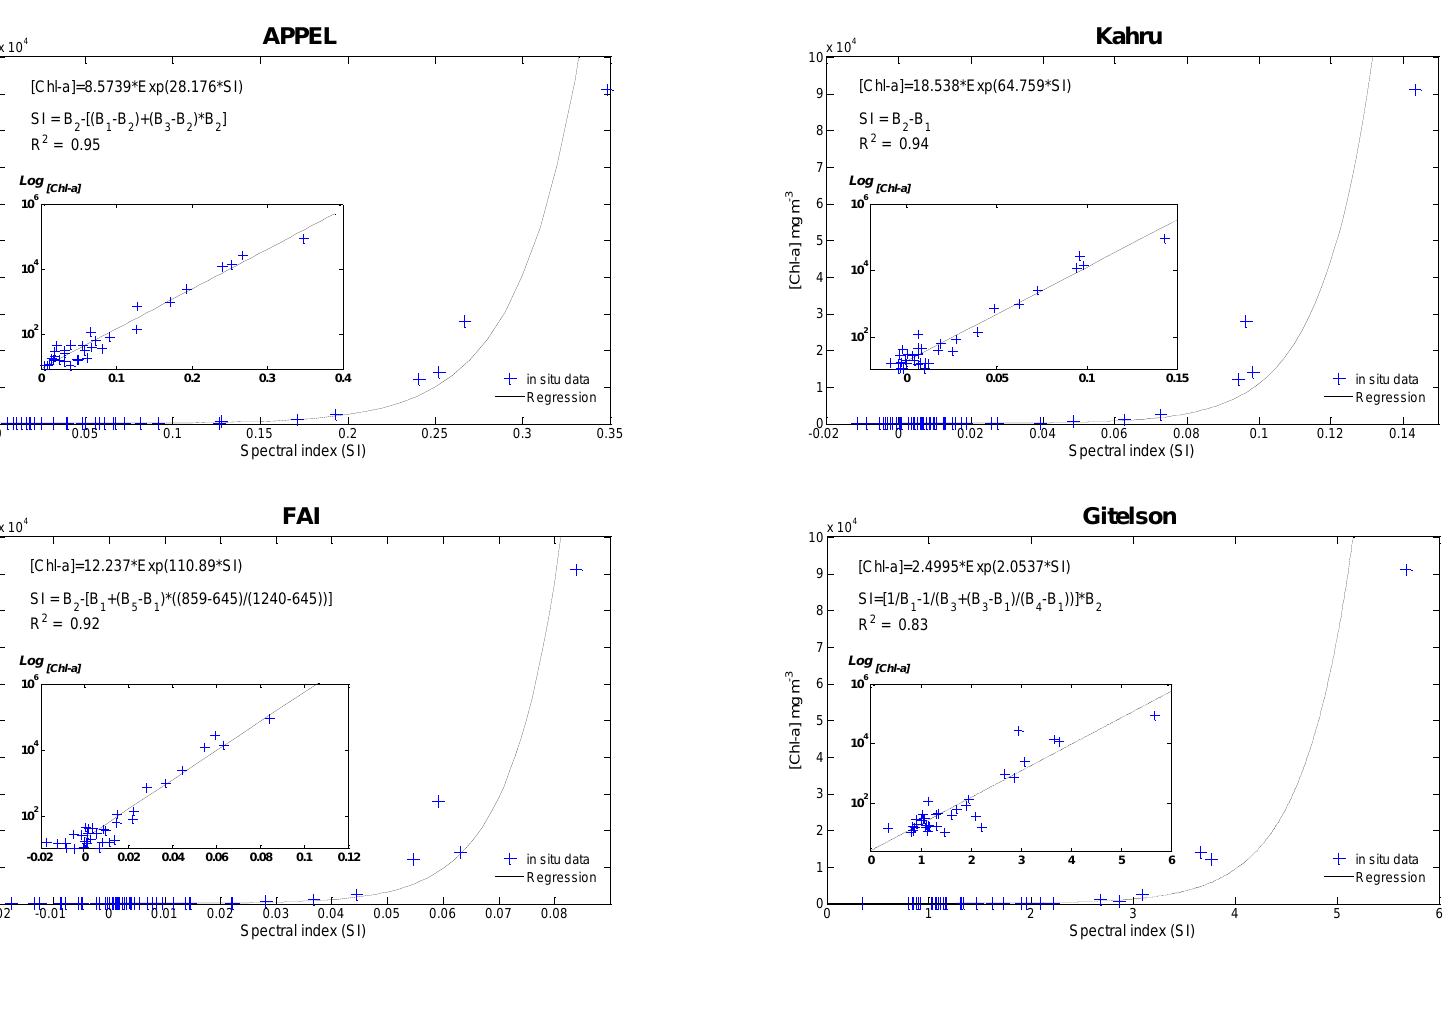
Figure 6. Exponential regression obtained between chlorophyll-a concentration (>10 mg∙m –3 ) and the outputs of the MODIS reflectance bands for the four models (y-axis of inserts is on a logarithmic